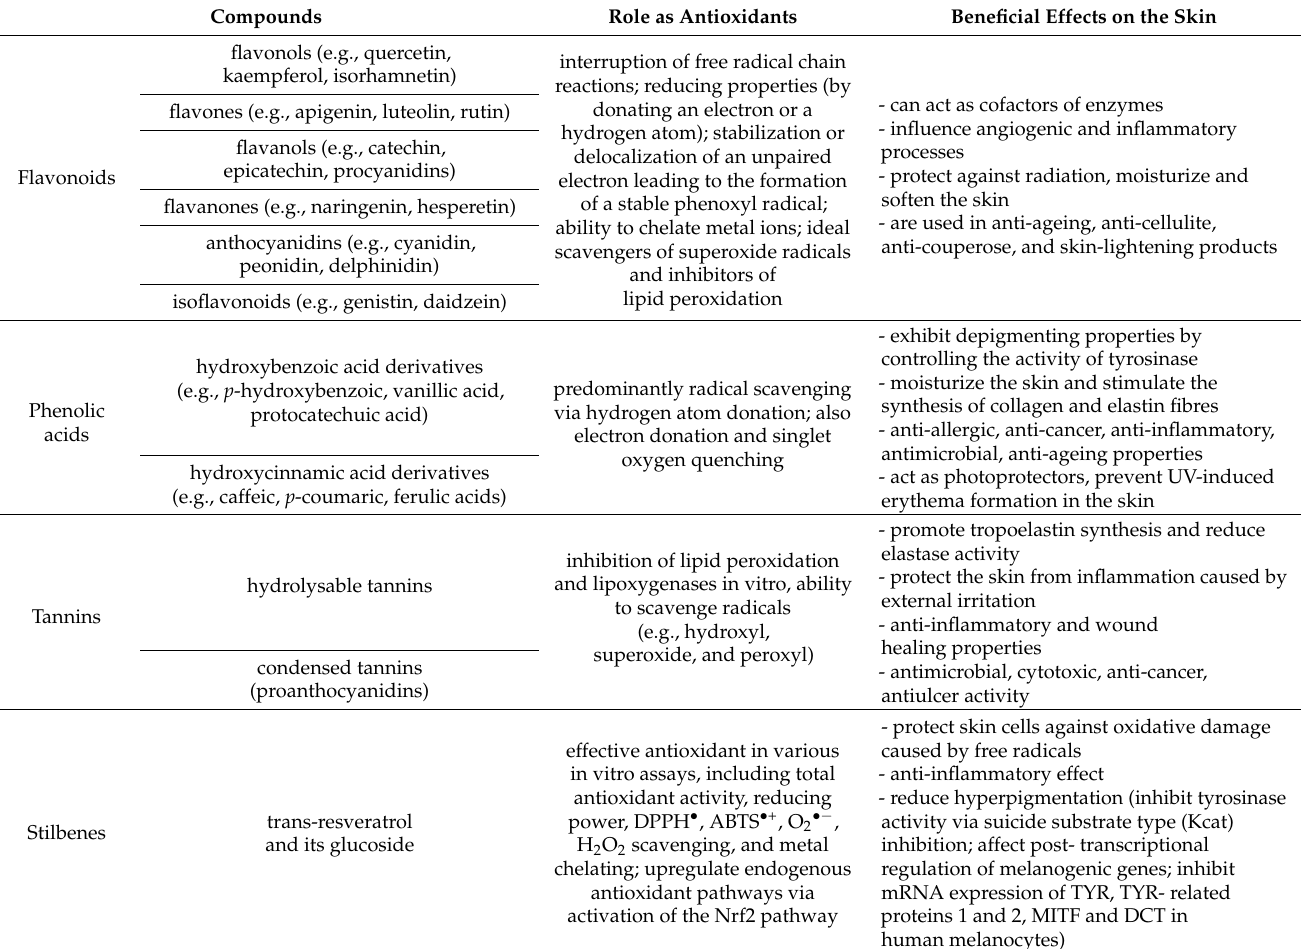
Table 2. Selected polyphenol compounds with antioxidant properties and their influence on the skin [21,23,35,36,40–42]. Role as